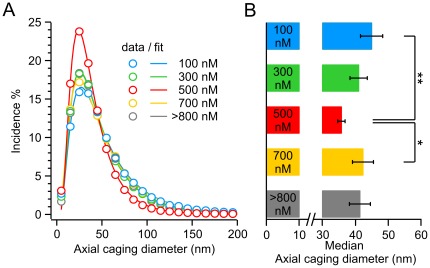
Reduced axial mobility at a free [Ca2+]i of 500 nM.(A) Average axial CD size distribution for each [Ca2+]i. The circles represent the averaged data points. The solid lines represent the best fit with a single log-normal component. Note that the peak amplitude at each [Ca2+]i is lower than the calculated average amplitude given in the results due to variations in the peak position of the CD histogram of each cell. (B) Median of the log-normal fits. Reduction indicates the axial immobilization of LDCVs at 500 nM free Ca2+. N100nM/n: 23/719; N300nM/n: 13/403; N500nM/n: 26/695; N700nM/n: 14/309; N>800 nM/n: 16/390; *P<0.05; **P<0.01.